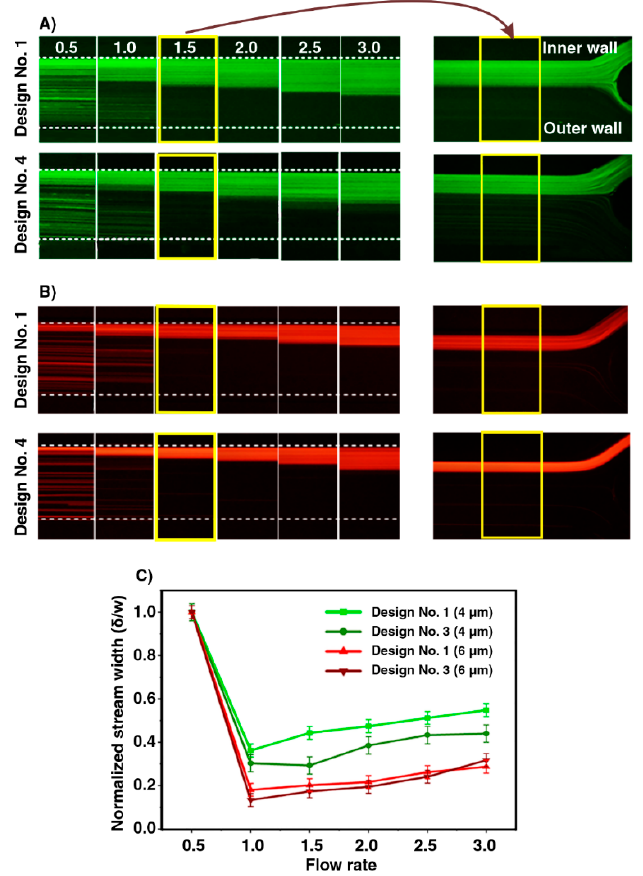
Figure 4. Fluorescent images illustrate the control of the particle stream width as a function of channel geometry at the flow rates ranged from 0.5 to 3.0 mL/min. ( A ) 4 µm particles through Design No. 1 and Design No. 4. ( B ) 6 µm particles within Design No. 1 and Design No. 4. Each column compares the position of focusing band at different cross-sections for different particle sizes. Particles in channel Design No. 4 migrate into well-ordered equilibrium positions under the influence of the F L and F D . ( C ) Normalized stream width ( δ is the width of the particle stream and w is the width of the channel) of 4 µm and 6 µm particles in Design No. 1 and Design No. 4 was plotted as a function of sample flow rate.